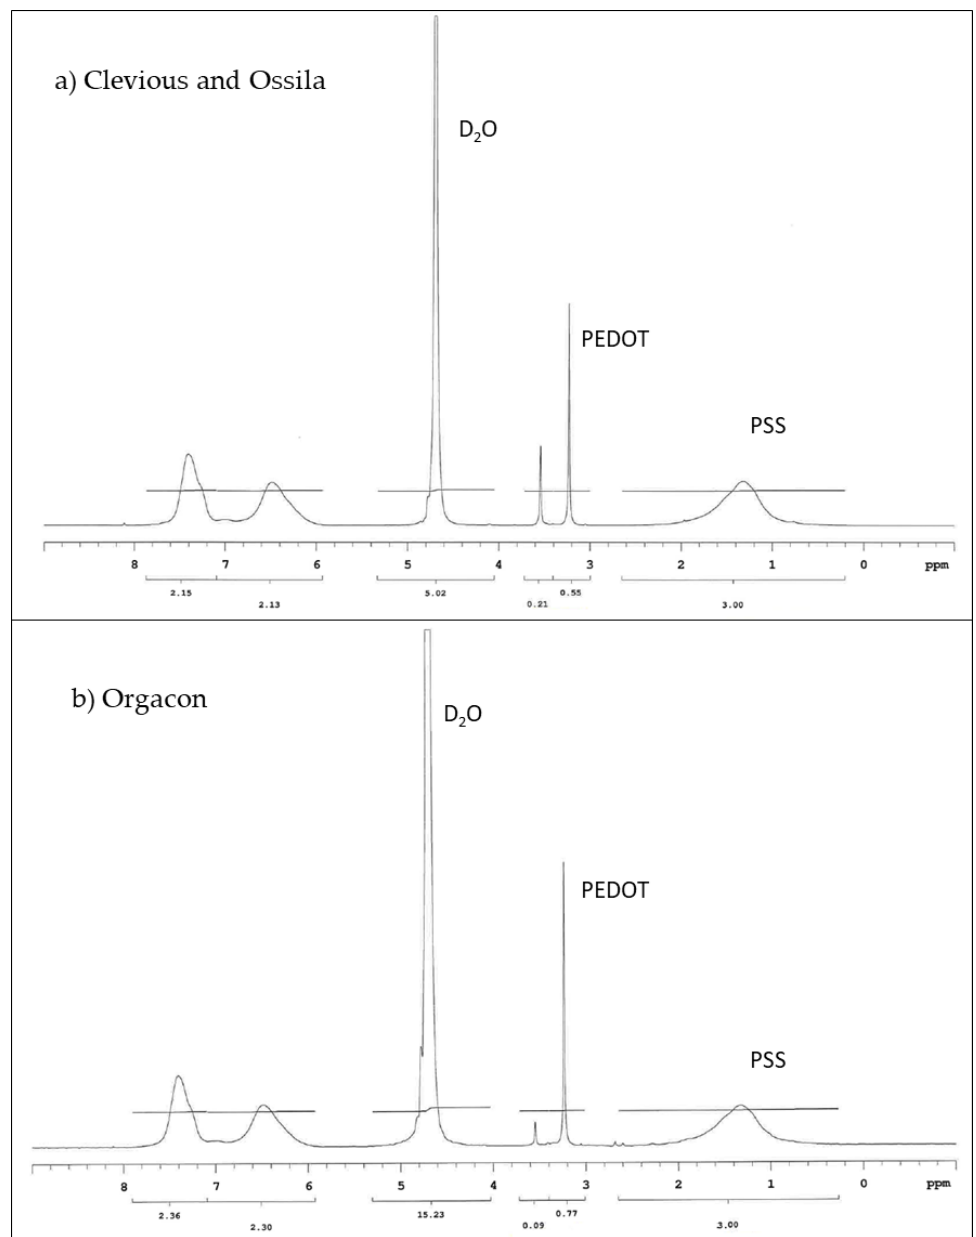
Figure 5. 1 H NMR spectra of PEDOT:PSS ( a ) Clevios and Ossila ( b ) Orgacon.